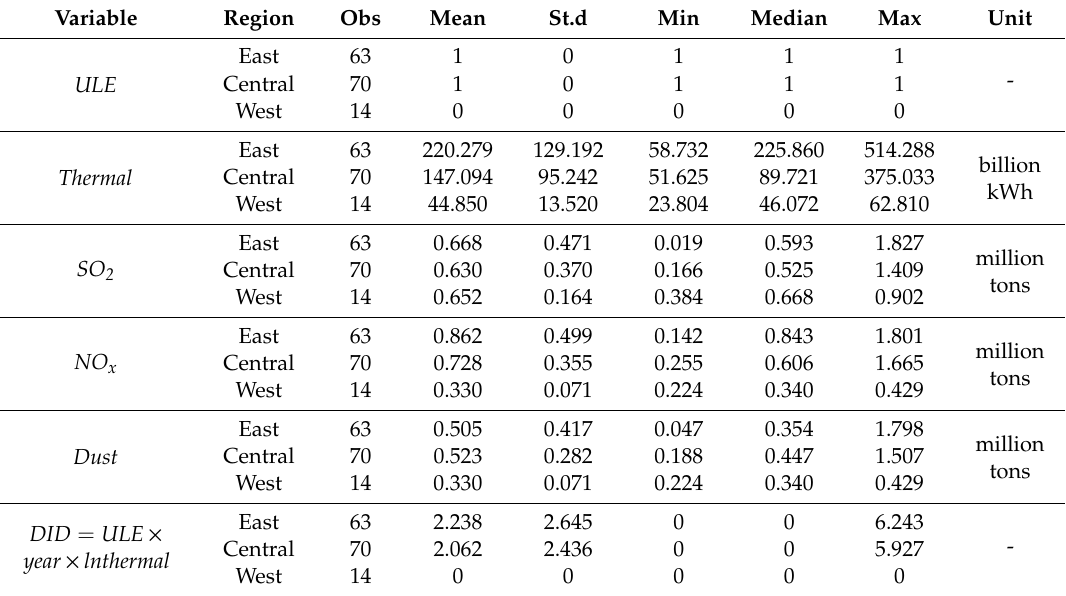
Table 3. Descriptive statistics of the main